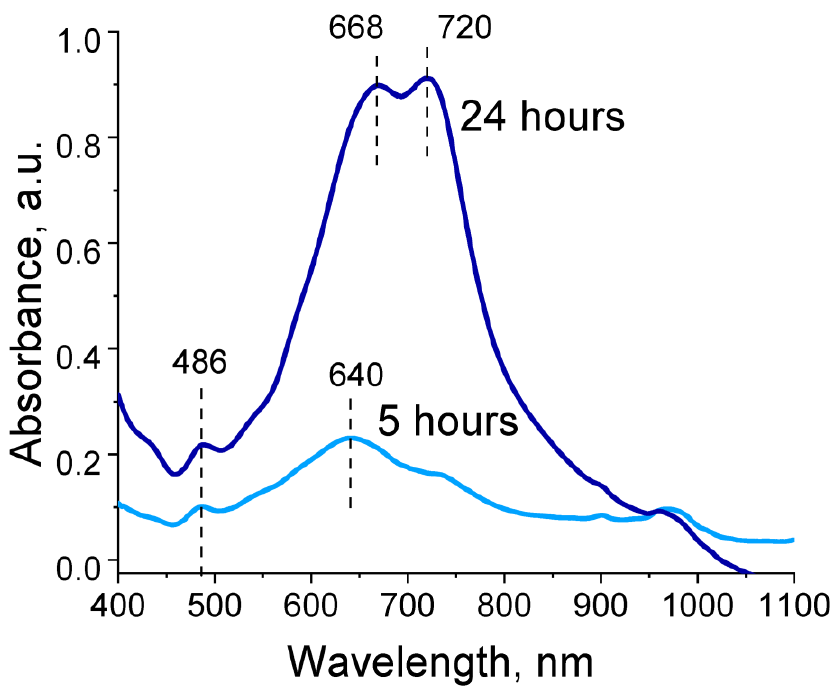
Figure 4. Optical absorption spectra of reaction dispersions during EDOT polymerization in the presence of P(SBMA-VA).